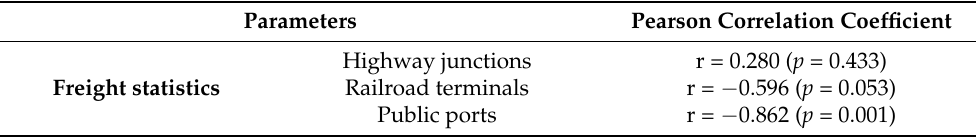
Figure 12. Travel times to public ports by industry category. Circles indicate outliners, an asterisk illustrates extreme outliners. Table 5. Correlation coefficients of different transport systems.